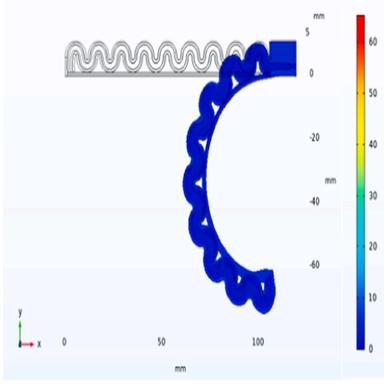
Finite element analysis - bending behavior under a pressure of 25 psi. Von Mises Stress .